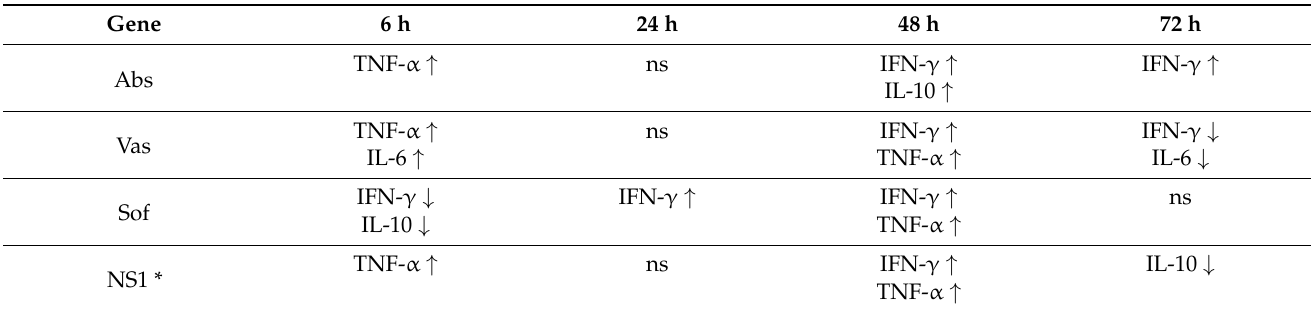
Table 1. Cytokine production in sera of NS1 gene-injected mice with statistically significant difference from vector-injected